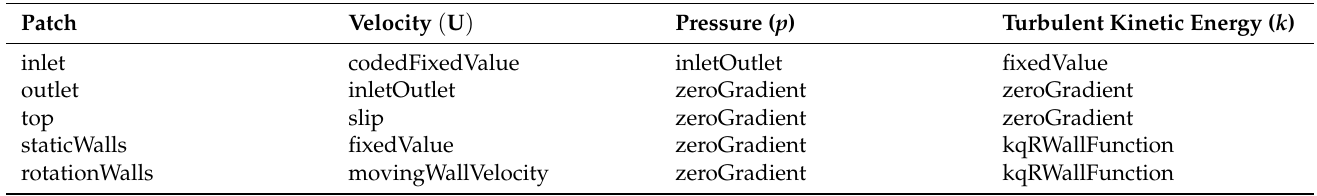
Table 3. The boundary conditions of each